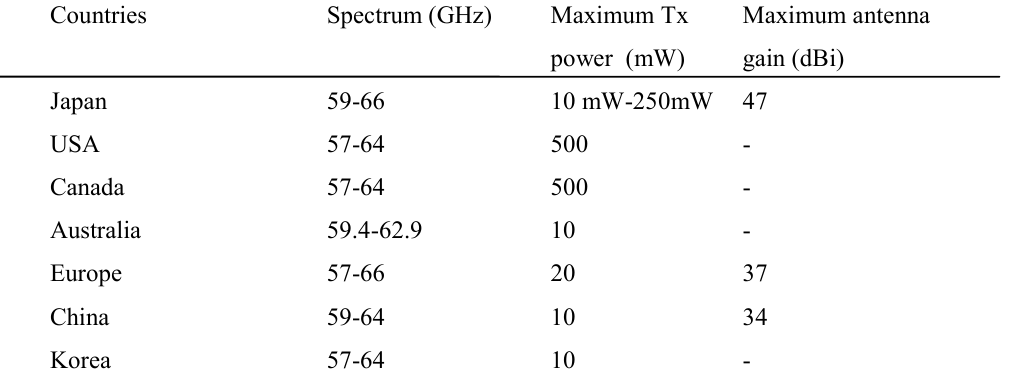
Table 1: Spectrum with maximum transmission power for 60 GHz